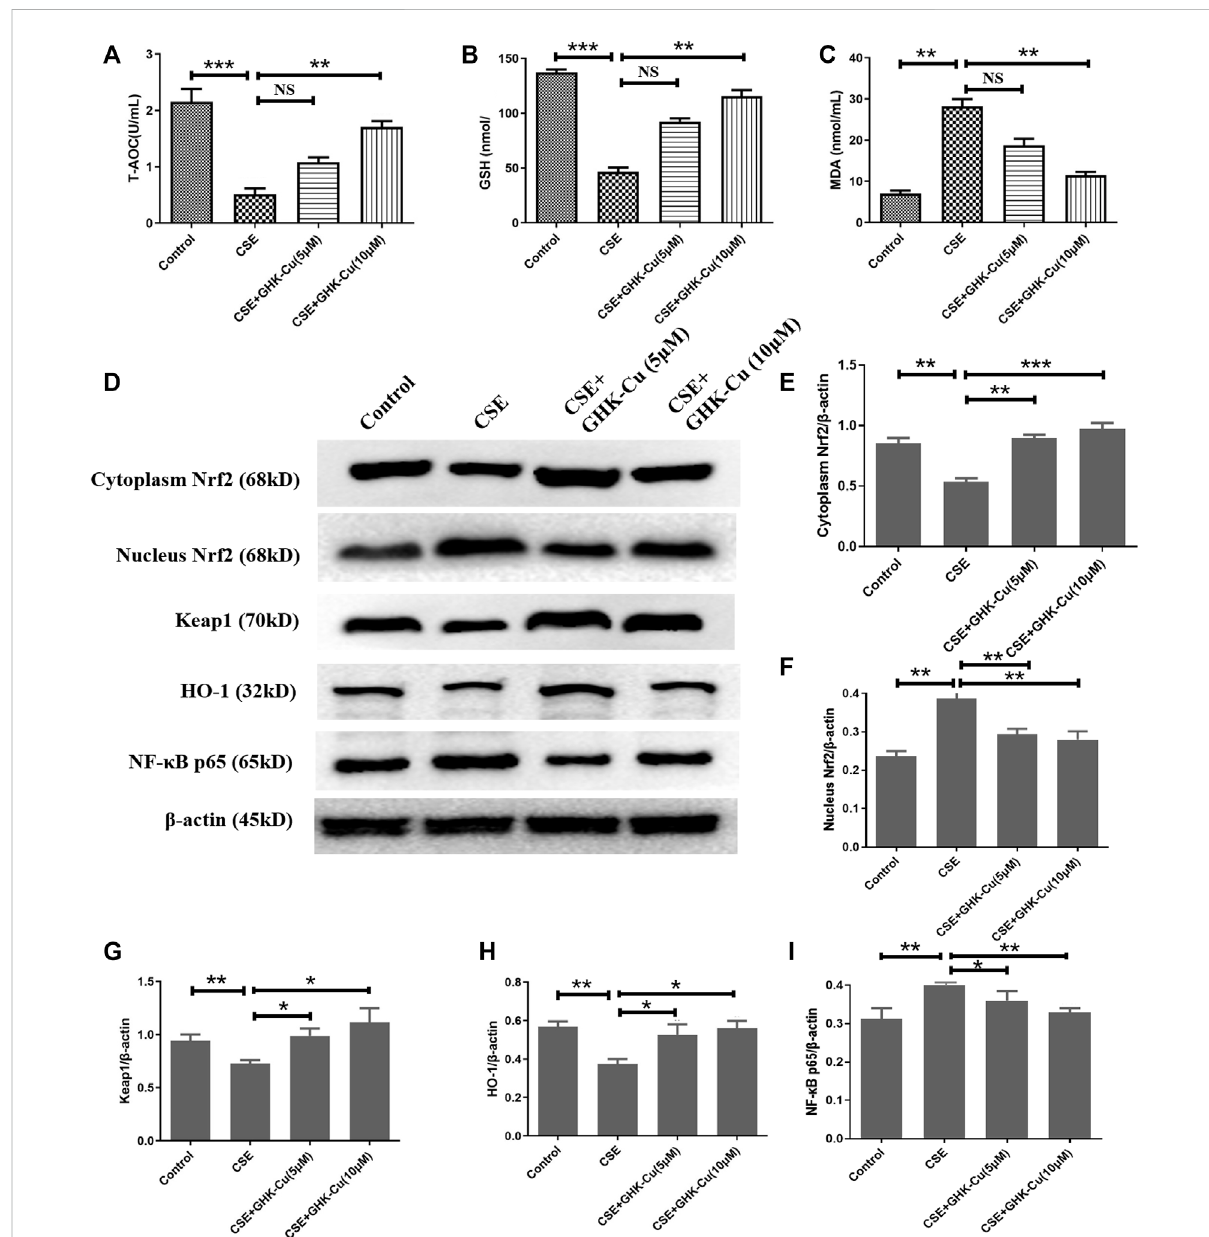
FIGURE 6 GHK-CuinhibitsoxidativestressinhumanalveolarepithelialcellsbyupregulatingNrf2levels invitro . (A – C) ThelevelsofT-AOC (A) ,GSH (B) and MDA (C) in A549 cells were detected. (D) The protein expression of Nrf2/Keap1 pathway and NF- κ B p65 in the cytoplasm and nuclei of A549 cells weremeasured. (E – G) WesternblottinganalysisofcytoplasmicNrf2 (E) ,nuclearNrf2 (F) ,Keap1 (G) ,HO-1 (H) andNF- κ Bp65 (I) proteinexpressionin the cytoplasm of the lung tissue from mice in different groups. * p < 0.05, ** p < 0.01 and *** p < 0.001, and NS means not signi fi cant ( p >